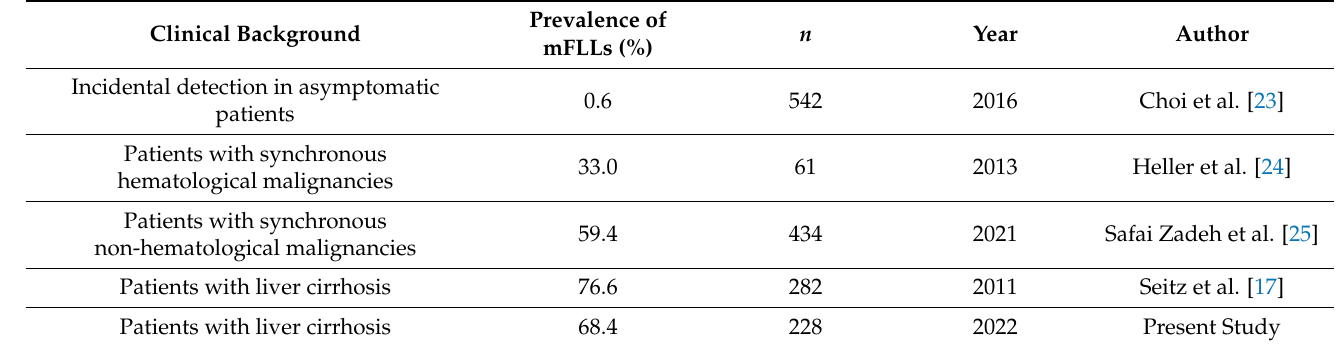
Table 4. The frequency of malignant FLLs, depending on the presence or absence of cirrhosis and non-hepatic primary malignant disease. FLL, focal liver